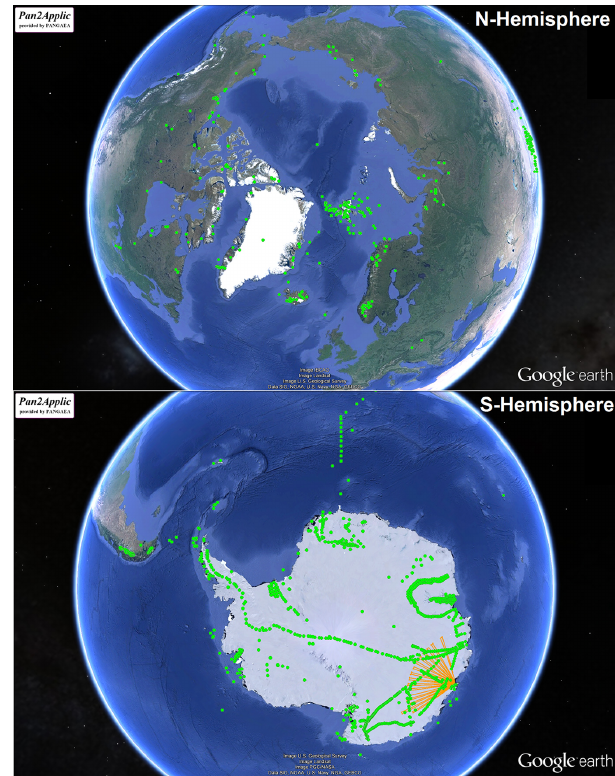
Figure 2. Overview of Arctic and Antarctic sample sites of the 450 IPY articles now stored in PANGAEA. Green denotes singu- lar events; the orange lines are from a radar sounding data set of Young et al.